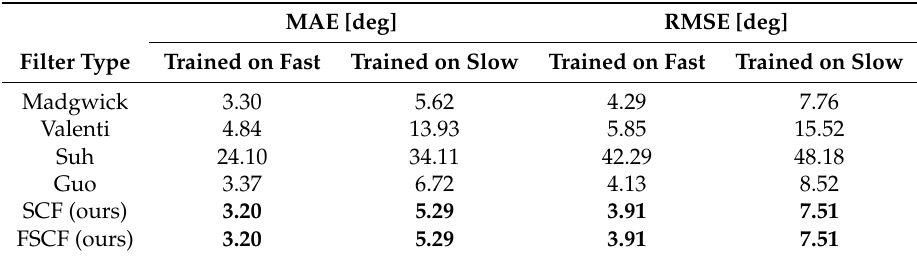
Table 3. Accuracy of the tested methods on testing data set. Parameters of all methods were trained either on the slow or fast rotation part of the data set. Reported accuracy is measured on the testing data, which is the remaining part of the dataset.